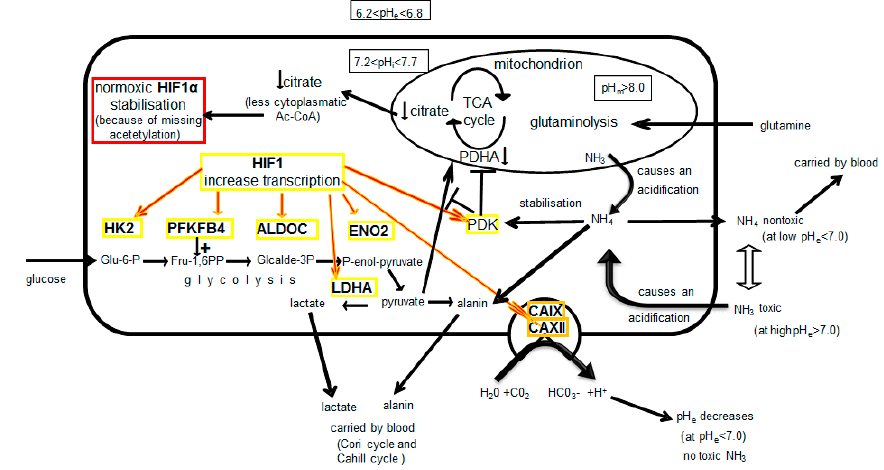
Figure 13. A model for the role of normoxic HIF1 in the regulation of glycolysis and glutaminolysis. The uptake of the amino acid glutamine and the subsequent deamination called glutaminolysis occurs at high rates in tumor cells [13]. The process of glutaminolysis is completed inside the mitochondria, and the mitochondrial pH value (pH m ) is higher than the pH value in the cytosol. This model demonstrates that the consumption of amino acids such as glutamine reaches a critical point for the pH value-dependent release of ammonia. As the catabolism of glutamine usually occurs in the mitochondrial matrix, the basic intra-mitochondrial pH value leads to the increased concentration of toxic ammonia. Gaseous